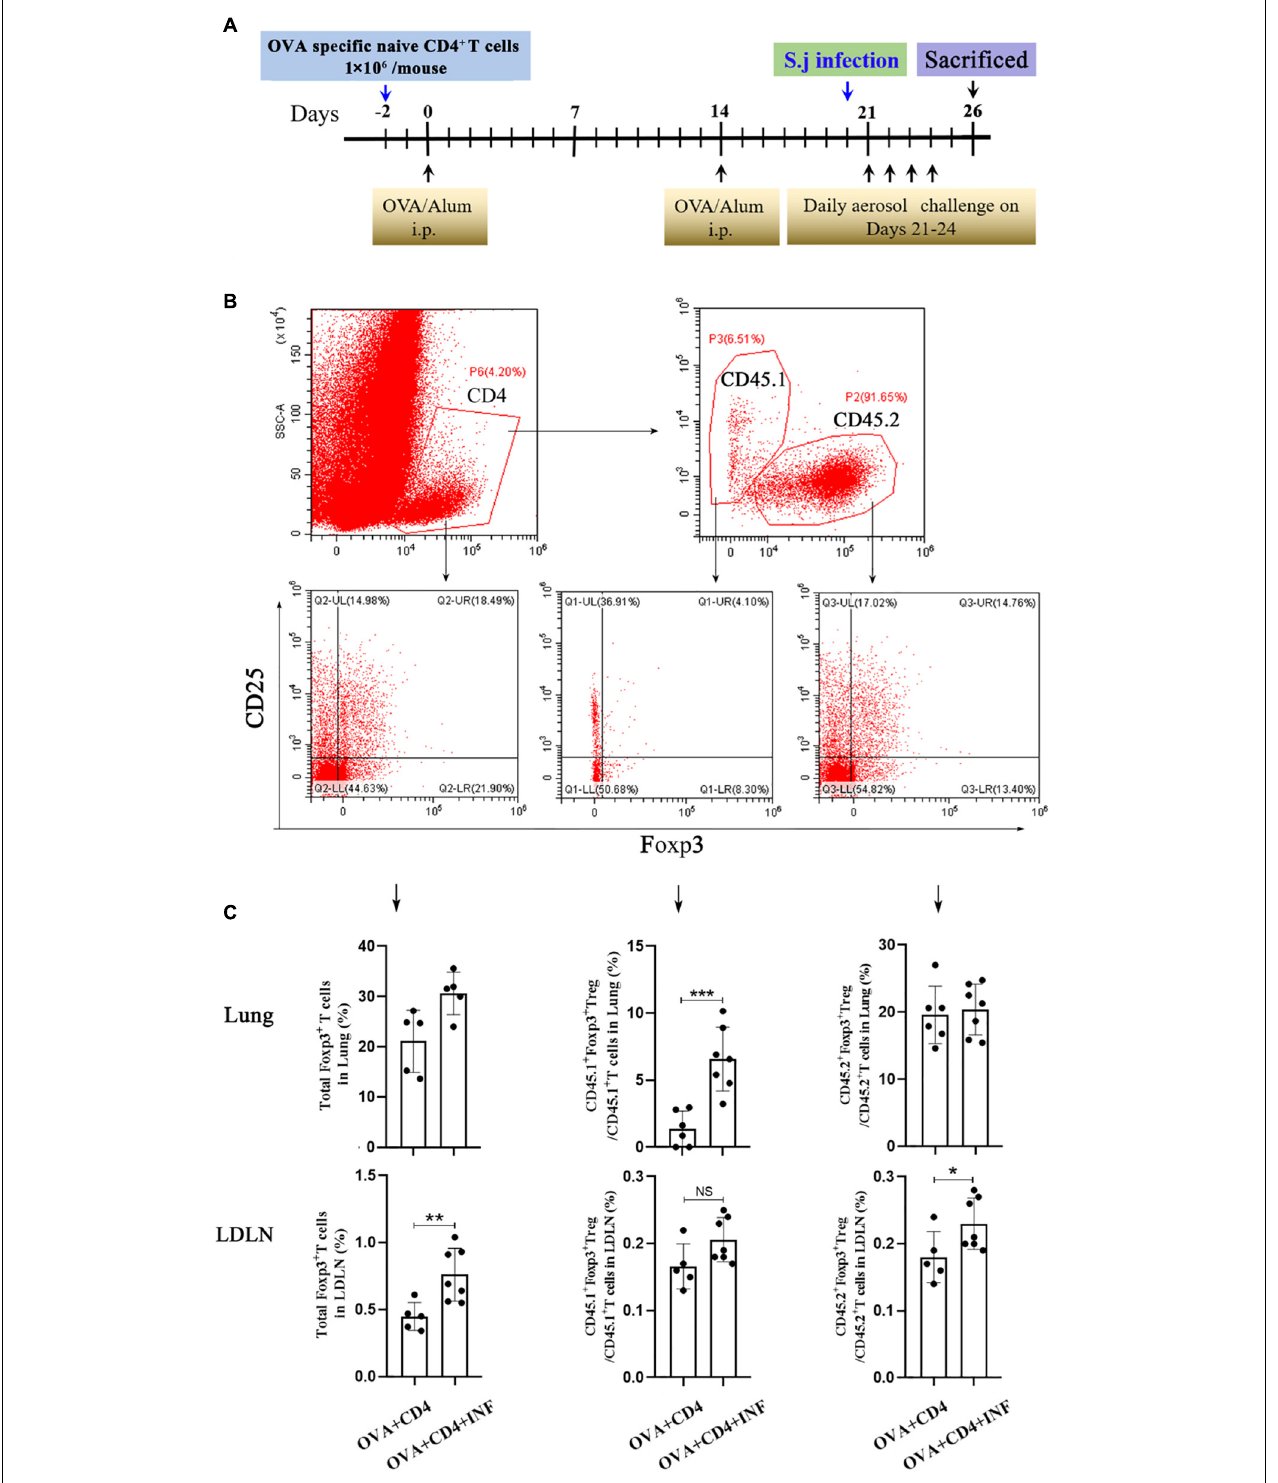
FIGURE 5 | Lung-stage S. japonicum infection upregulated OVA-specific Treg cells after OVA challenge. (A) Design of experiment for testing the protective effect of lung-stage S. japonicum infection on OVA-induced AAI after adoptive transfer of OVA-specific naive CD4 + T cells. (B,C) Gate strategy and statistical comparisons of flow cytometry analysis for total Treg, CD45.1 + Treg cells (OVA-specific) and CD45.2 + Treg cells in lung and lung draining lymph nodes (LDLN). n = 5 or 6 mice per group, experiment performed twice. * P < 0.05, ** P < 0.01, *** P < 0.001; NS, not significant by the one-way analysis of variance (ANOVA) with Tukey test.